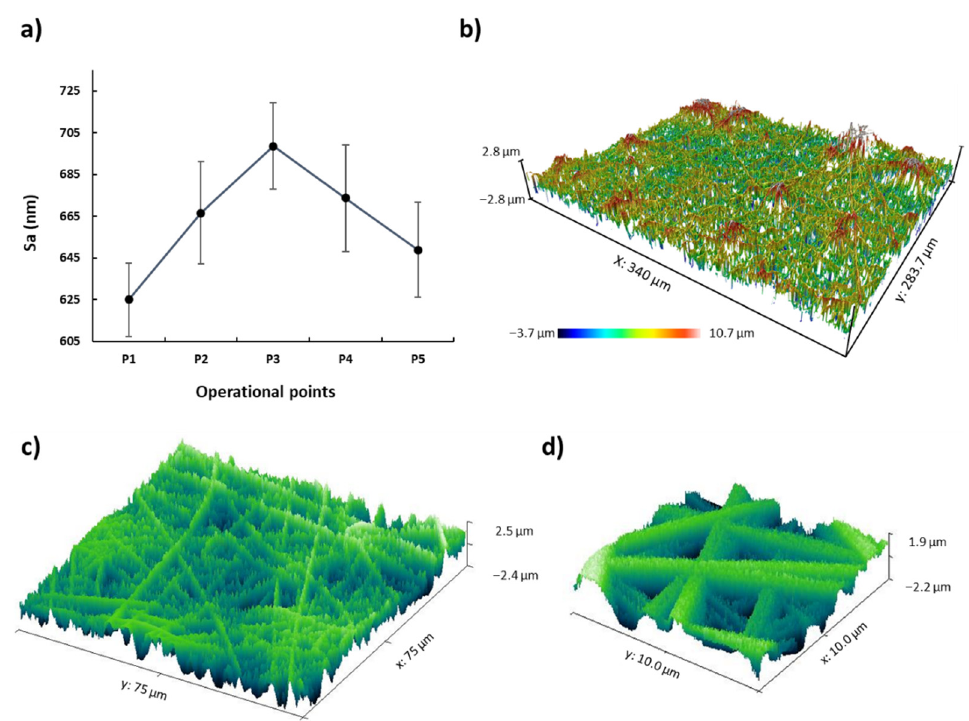
Figure 9. ( a ) Evolution of the average surface roughness (Sa) as a function of the operational points (P1, P2, P3, P4, and P5). 3D images representing the surface morphology of the electrospun mats in sample S3 (2000 µL/h and 17.7 KV) with the ( b ) confocal microscope and AFM ( c , d ) in the scale of 75 µm and 10 µm, respectively.